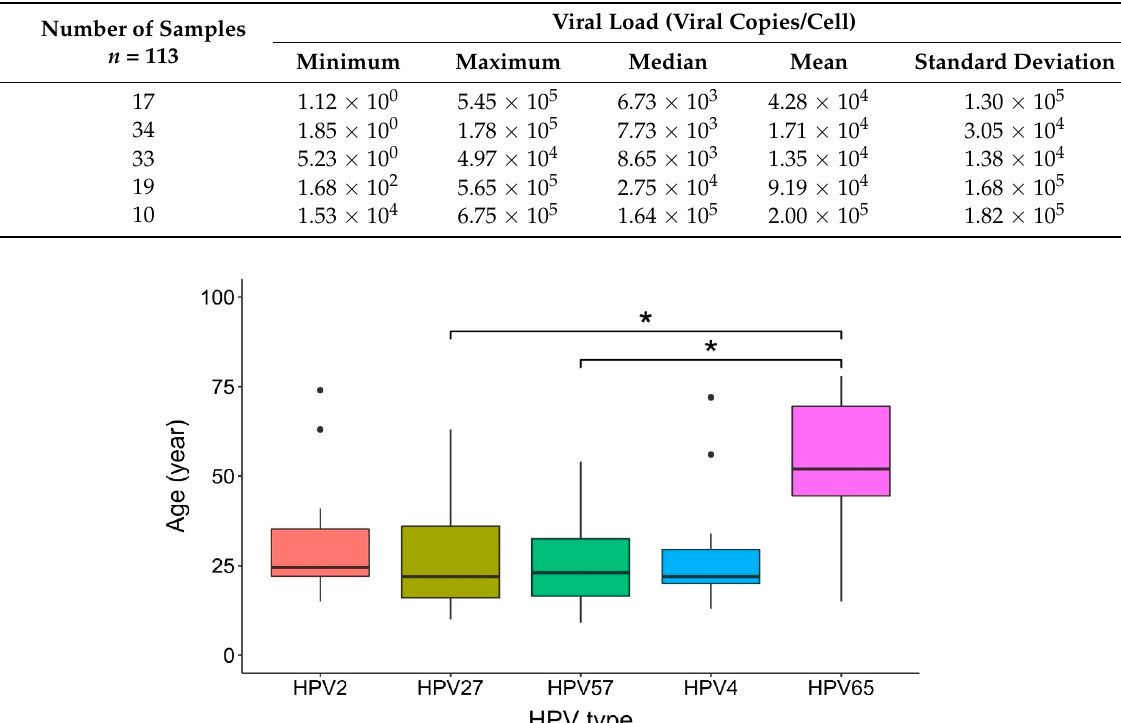
Comparison of the size of common warts at various anatomical sites among different causative HPV types using the Kruskal–Wallis test revealed that HPV4 was etiologically